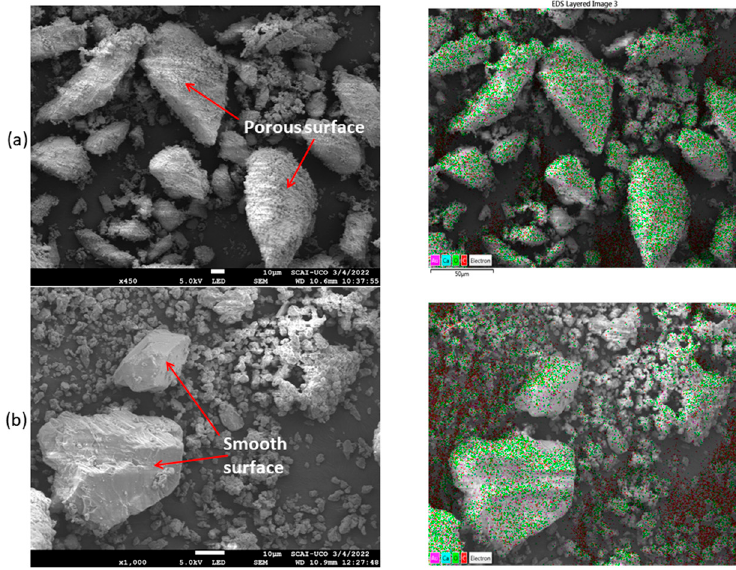
Figure 7. SEM images of ( a ) Seashell filler (SF) and ( b ) Limestone filler (LF).